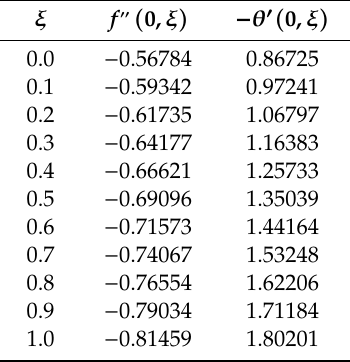
Table 2. − θ (cid:48) ( 0, ξ ) and f (cid:48)(cid:48) ( 0, ξ ) exact solutions found through the di ff erent procedure for the ξ as